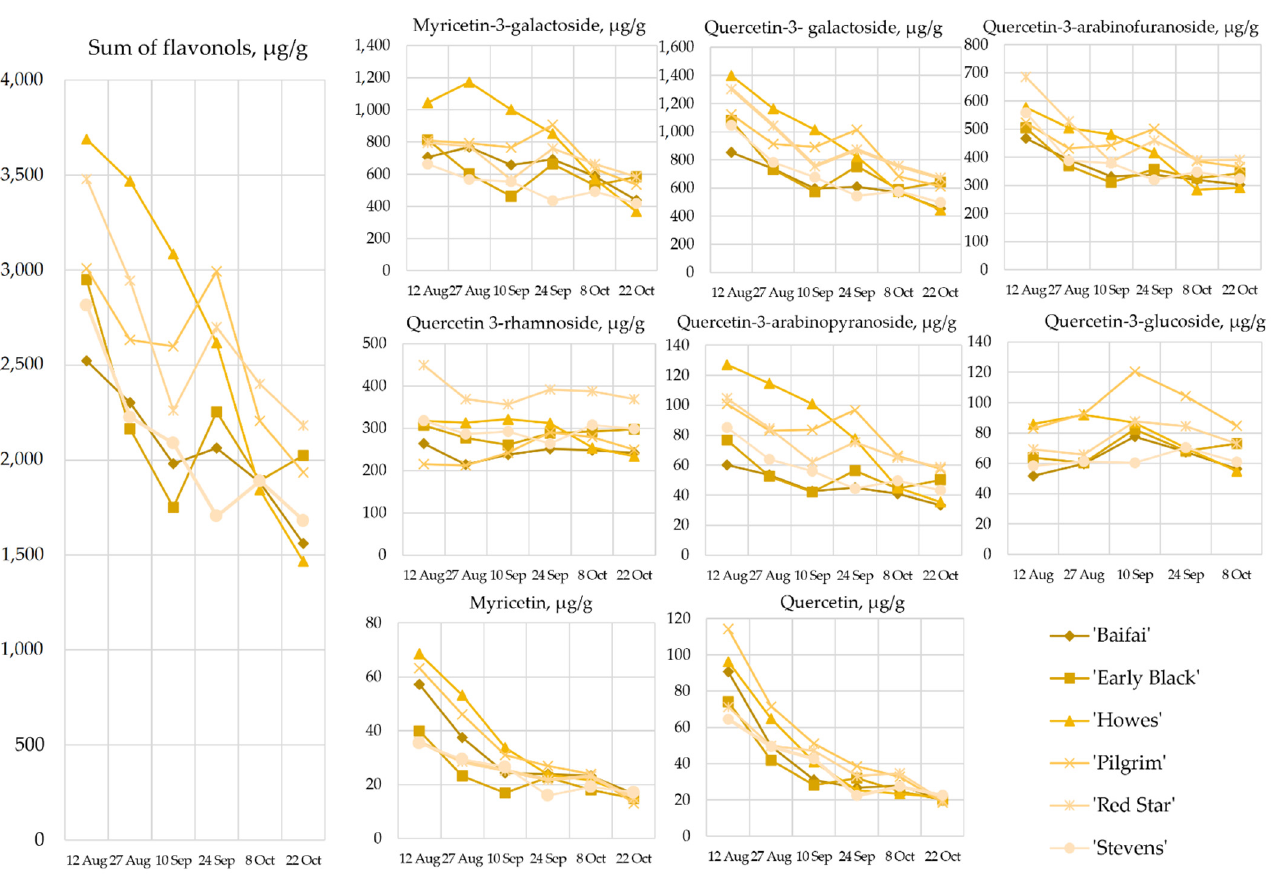
Figure 3. Variability of flavonols content in large cranberry samples during ripening.